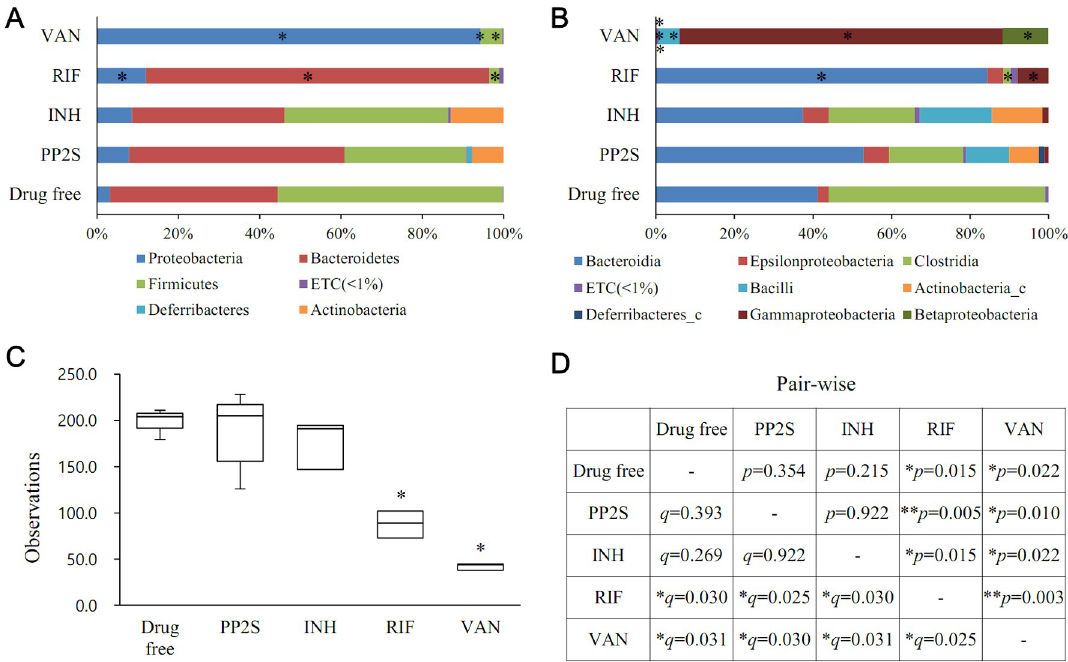
Fig 6. Gut microbiota changes after drug treatment. (A and B) Effects of drugs on intestinal microbiome were investigated through 16s rRNA gene-based metagenomics analysis. Compared to the drug-free control group, the microbiome distribution was significantly changed in the group administered with RIF or VAN but did not show any significant change in the group treated with PP2S or INH ( � p < 0.05). (C) A phylogenetic diversity analysis to investigate the biodiversity of intestinal microbiome upon administration of each drug ( � p < 0.05). (D) A beta set-significance analysis was performed using permutational multivariate analysis of variance (PERMANOVA) based on Jensen–Shannon distances to show associations of gut microbiomes between groups ( � p < 0.05, �� p < 0.01, � q < 0.05). INH, isoniazid; RIF, rifampicin; VAN, vancomycin. Data underlying this Figure can be found in S1